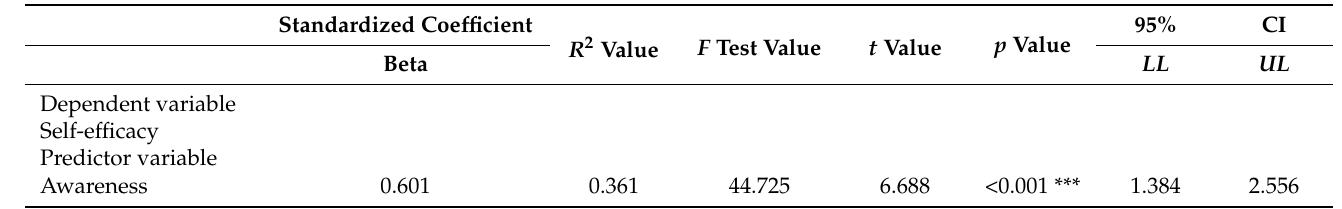
Table 8. Predictivity analysis between awareness of fire prevention and emergency response and self-efficacy (N =